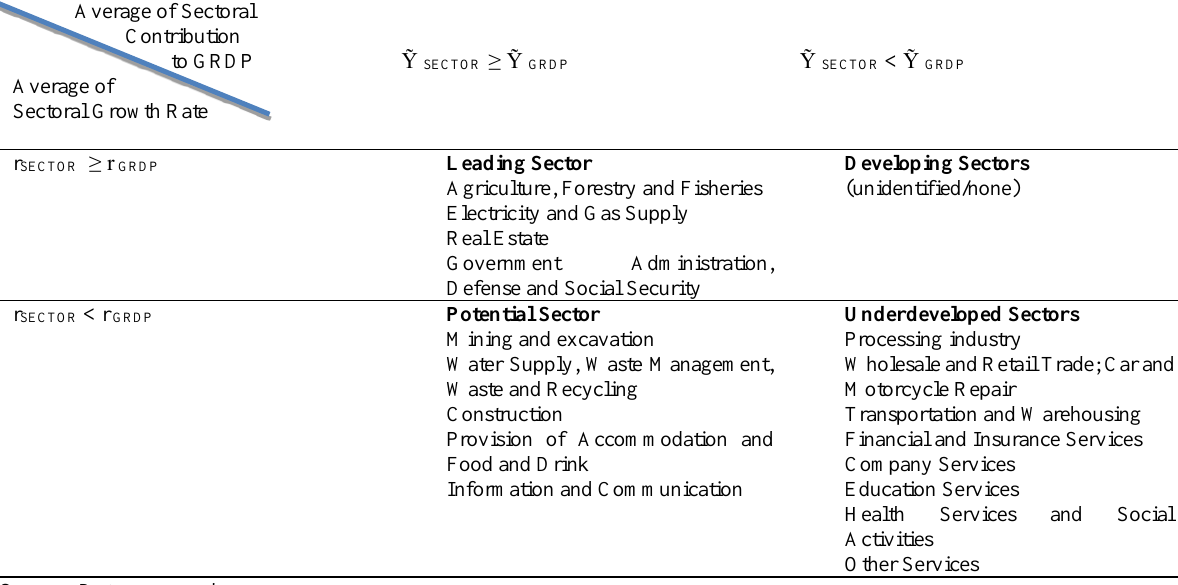
Table 5: Classifying Each Sector into a